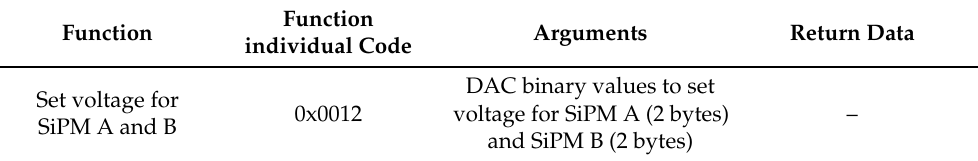
Table 4. CAN transaction for setting SiPM